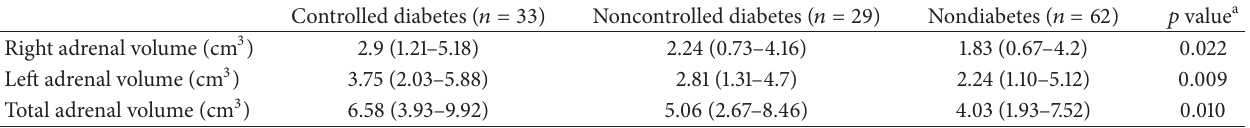
Table 4: Adrenal volumes in controlled and uncontrolled diabetic patients and control